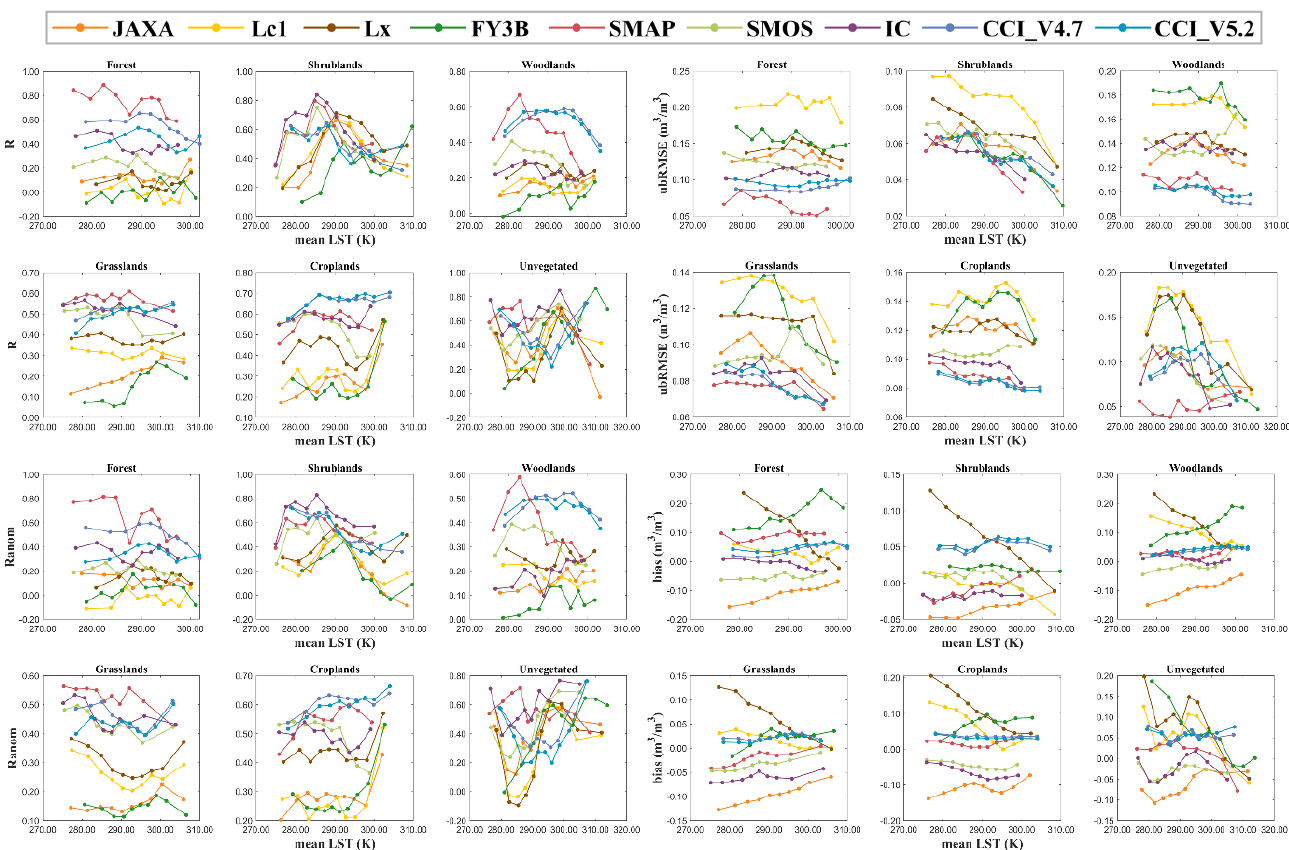
Figure 10. Line-charts of R, Ranom, ubRSME, and bias for each product varying with LST, conditioned by LC types.